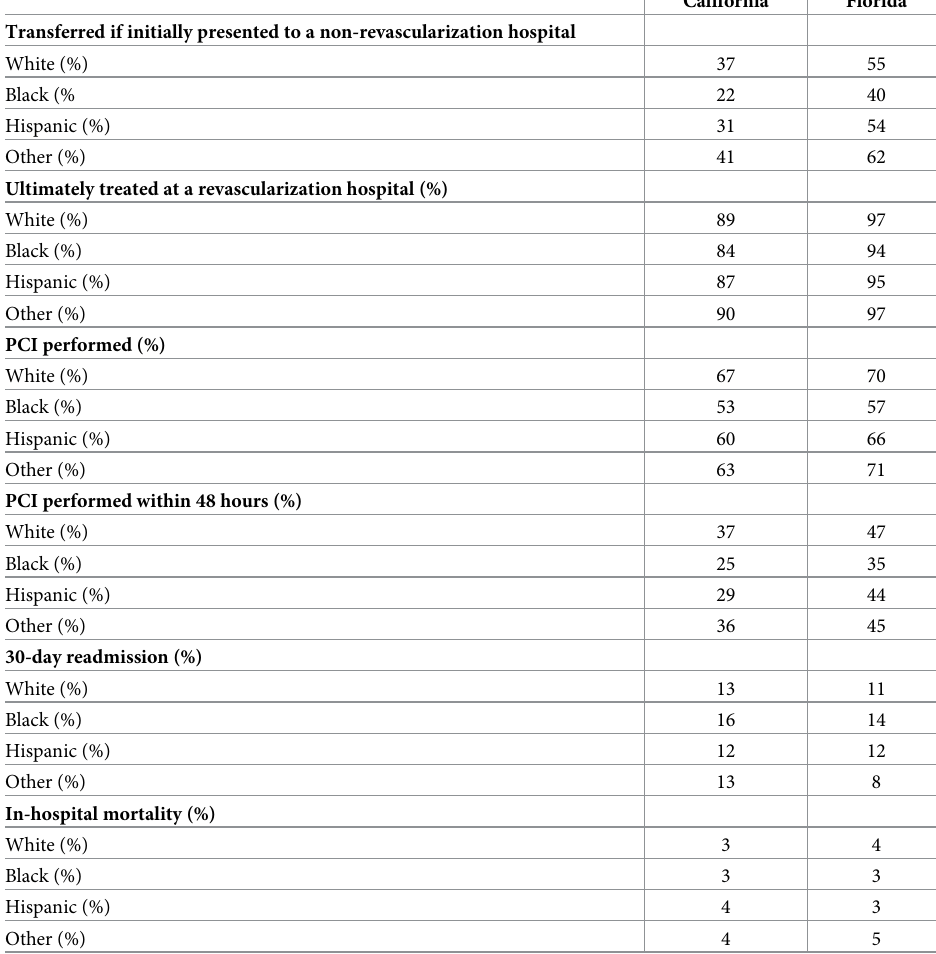
Table 2. Summary statistics of pre-intervention outcomes by state and